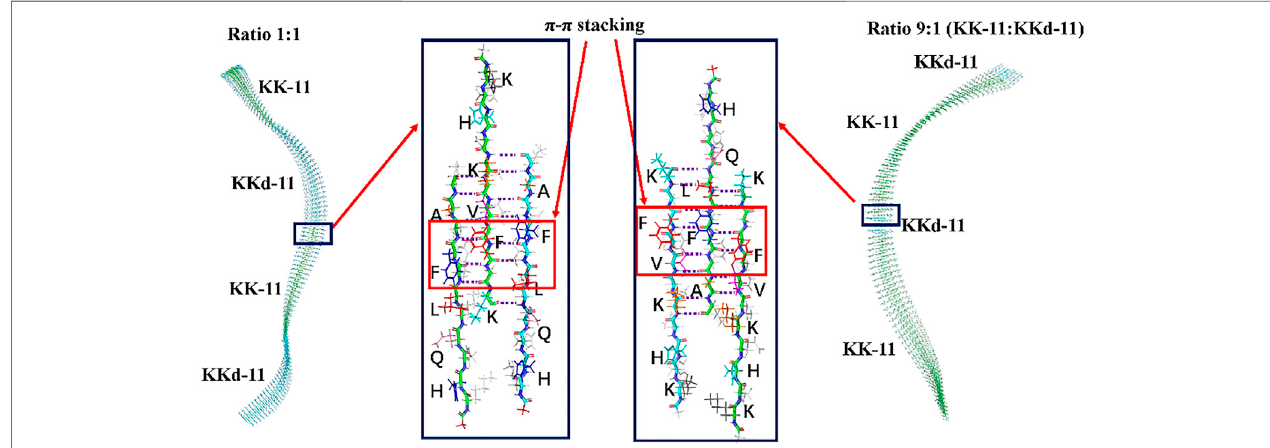
FIGURE 7 | The co-assembled structures were composed of short helical fragments of KK-11 and KKd-11. The junction structures are enlarged in the blue rectangles, in which the hydrogen bonds formed between the hydrophobic region (LVFFA) are shown and the π - π stacking is highlighted with red rectangles. (A) The sidechains of amino acids protruding to the reader; (B) The sidechains of amino acids protruding to the back. The right three peptides were obtained by rotating the left three peptides 180 ° to illustrate both sides of the amino acids ’ sidechain clearly, with the side that opposite to the reader colored by light grey.